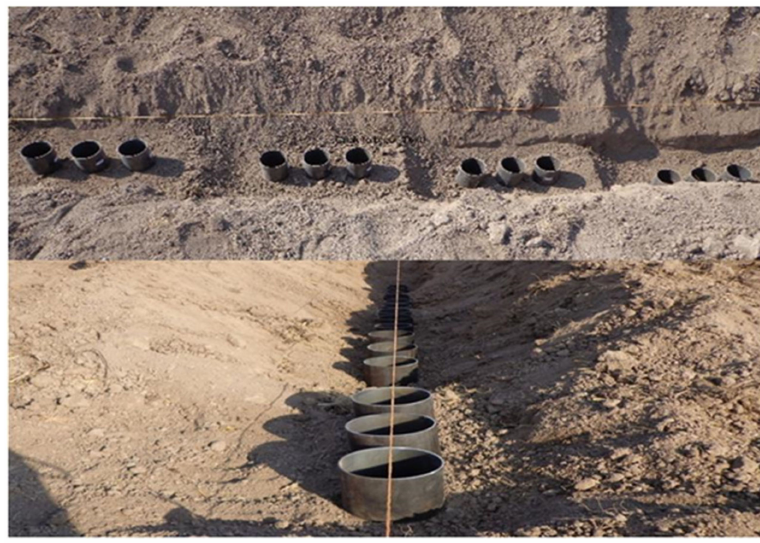
Figure 3. Placement of the cylinders inside the soil